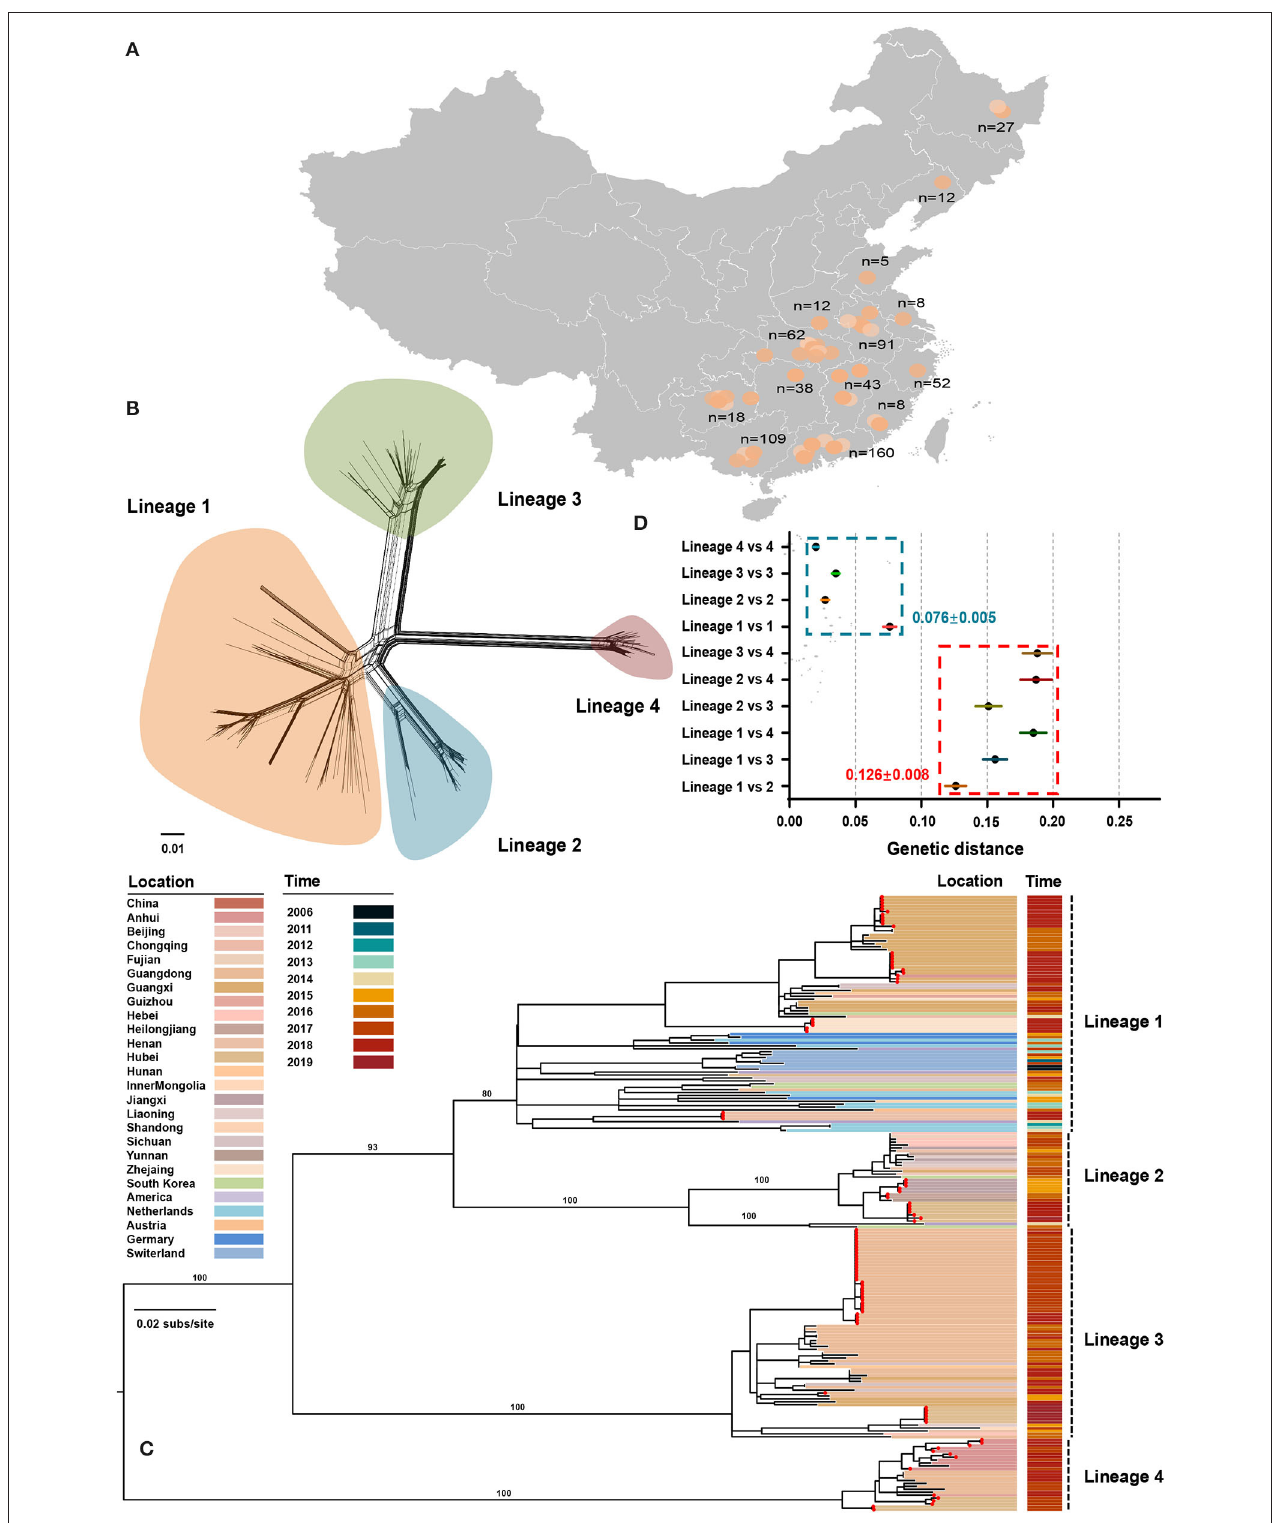
FIGURE 1 | Phylogenetic relationships between atypical porcine pestivirus. (A) Map showing the sampling locations selected in this study. (B) Splits network analysis of 211 E2 sequences. The pairwise homoplasy index test did not find significant evidence for recombination ( p = 0.45). (C) Maximum-likelihood phylogeny based on 211 E2 sequences with sampling locations and dates from 2006 to 2019. Red dots indicate the strains sequenced in this study. The scale bar is given in substitutions/site. (D) Evolutionary divergence analysis between and within lineages.